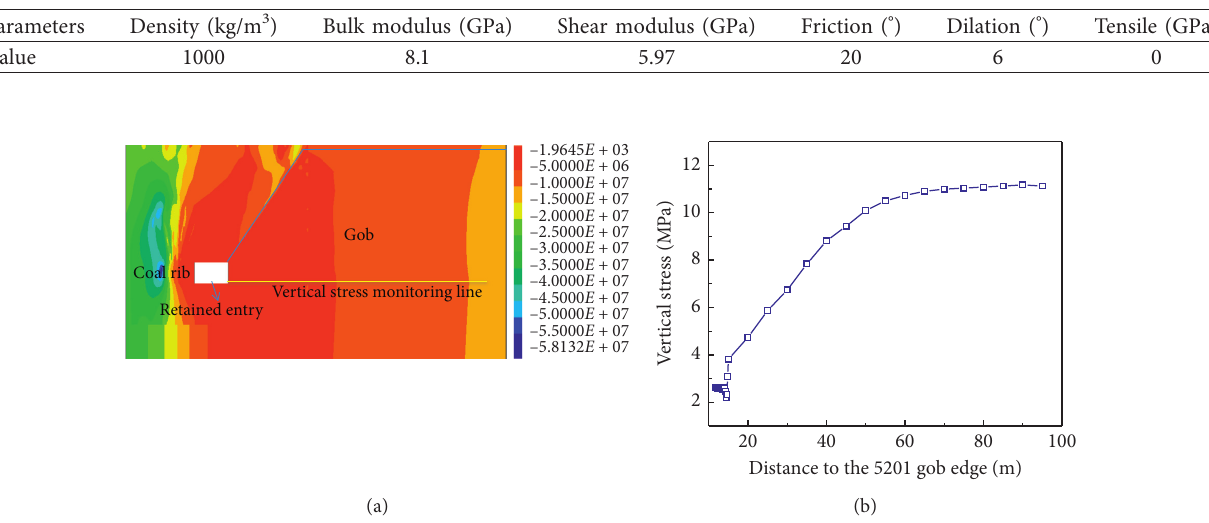
Figure 9: Comparison of simulation and analytical results. Table 6: Material parameters of gangue in gob.